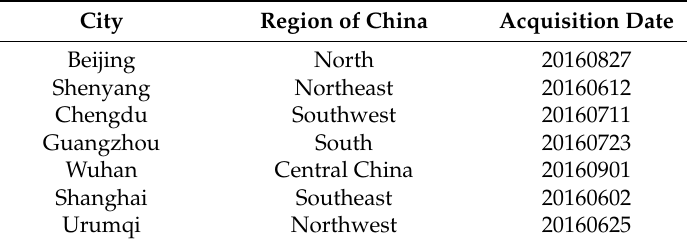
Table 2. Area and acquisition date of